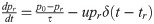
(A) A binary asymmetric channel with a finite memory is used to model the release site under short-term depression. The synchronous release probability, pi, and the asynchronous release probability, qi, are determined based on the previous L release outcomes of the release site. (B) The algorithm for calculating the synchronous spike-evoked release probability, pi, given the last L release outcomes, (Yi−L, Yi−L+1, …, Yi−1). The asynchronous release probability, qi, can be derived similarly by substituting c, e and p with d, f and q respectively. We assume that the model parameters (α, c, d, e, f, p0, q0) are strictly greater than zero and less than one. The seed value of the algorithm, u0, is set to p0 for synchronous release and q0 for asynchronous release. (C) The performance of the algorithm is compared with the stochastic model of depression [22]. The stochastic model is based on the differential equation dprdt=p0-prτ-uprδ(t-tr), where pr, τ, p0, u, and tr are the release probability, recovery time constant, default (maximum) release probability, depression coefficient and the release timing. At the bottom of the panel, the orange stem plot shows the timing of the release, tr, during an interval of 200 msec. The orange line demonstrates the release probability, pr, calculated from the differential equation. By assuming a time unit of Δ = 10 msec for the MRO model, the 200 msec interval corresponds to a memory of length L = 20. The memory content of the model is shown at the top of the panel. The blue line demonstrates the release probability calculated from the algorithm in (B). The final values of the release probability are indicated by filled circles. (D) Every arbitrary state of the release site can transit to two other states, depending on the release outcome. The transition probabilities are shown on the transition links.